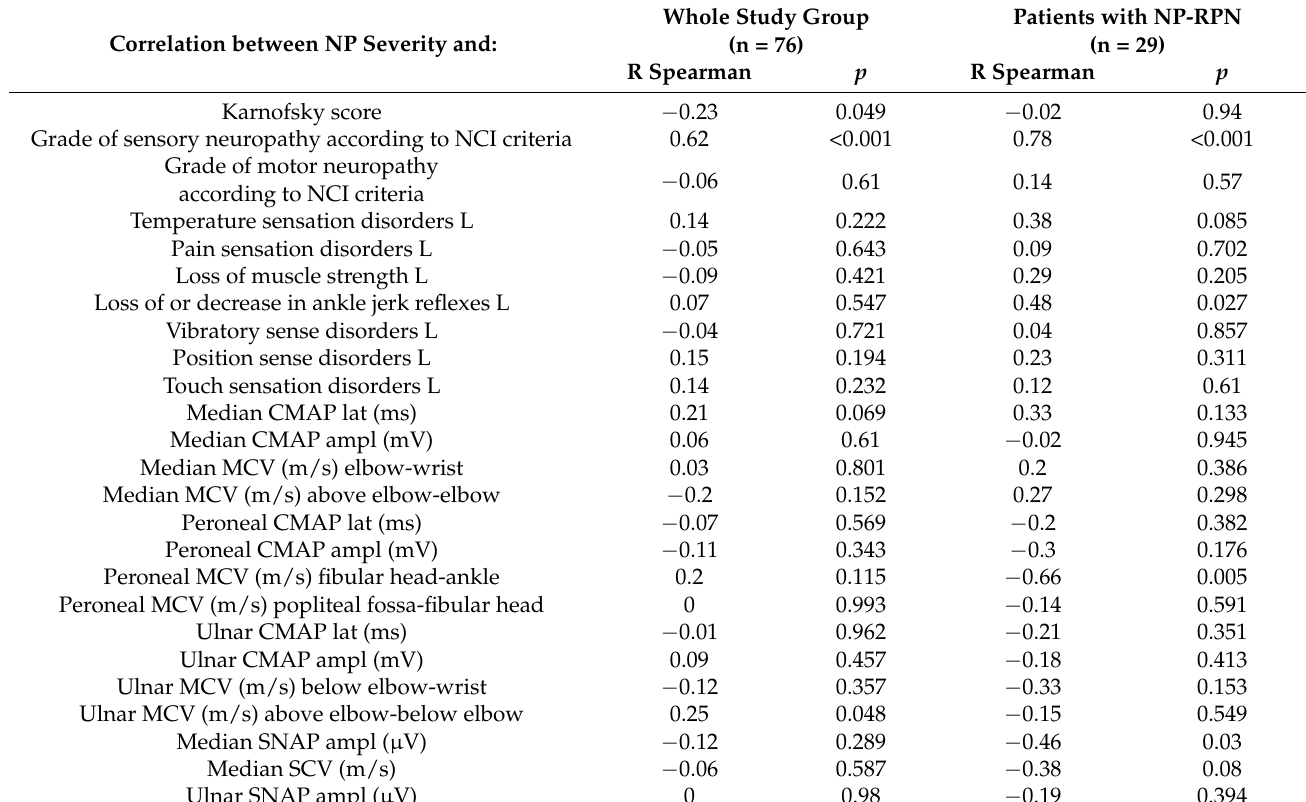
Correlation between NP Severity